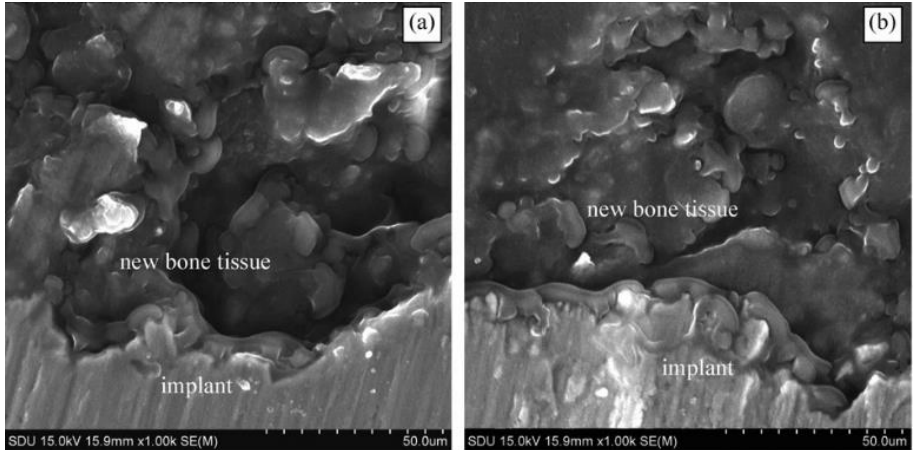
Figure 2. Morphologies of the implants after embedding for 3 months. ( a , b ) are the SEM morphologies of 200 and 600 °C films. (Reprinted with permission from [52]. Copyright 2013 Elsevier).